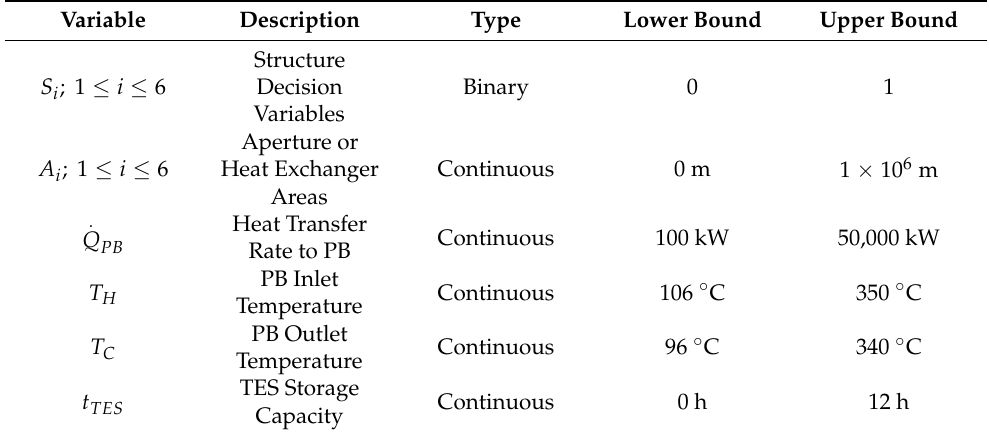
Table 1. Lower and upper bounds of the hybrid solar–waste heat power plant decision